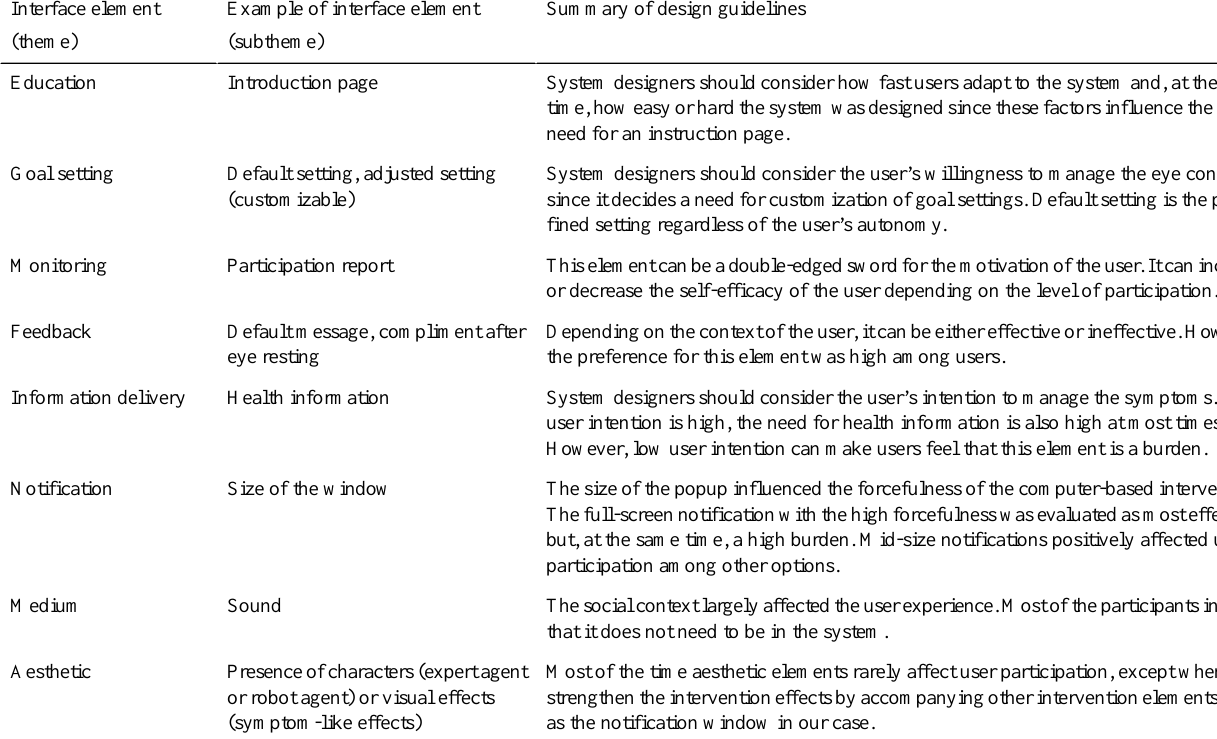
Table 5. Summary of design guidelines for interface